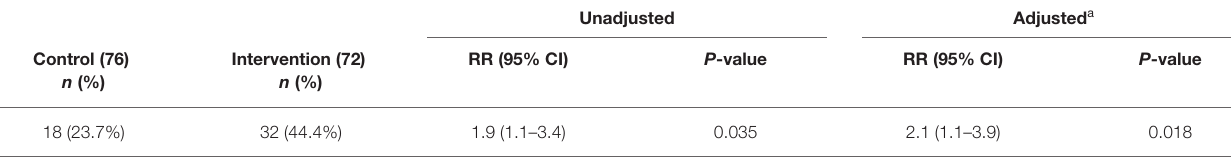
TABLE 4 | Proportion of participants who achieved normoglycemia (HbA1c < 5.7%) at 6